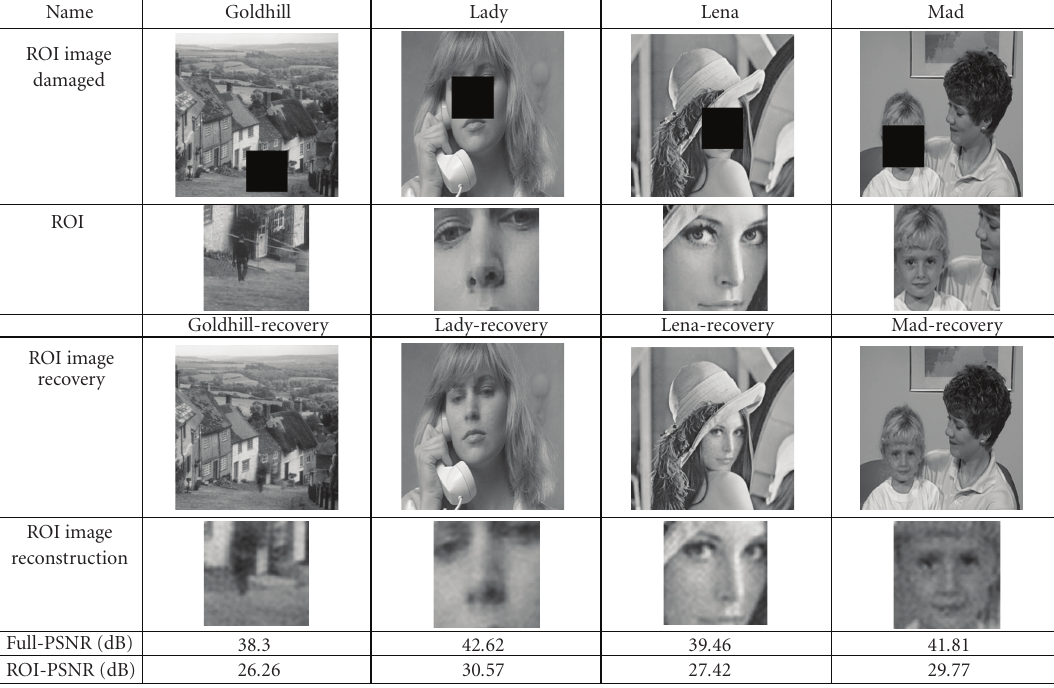
Figure 10: The error recovery with ROI image